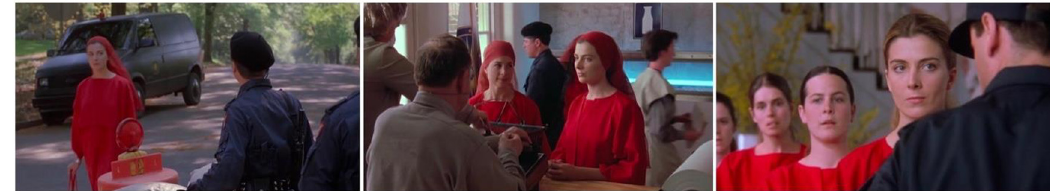
Figure 1: Seeing O ff red/Kate ( Natasha Richardson ) looking in Schlöndor ff ’ s The Handmaid ’ s Tale .